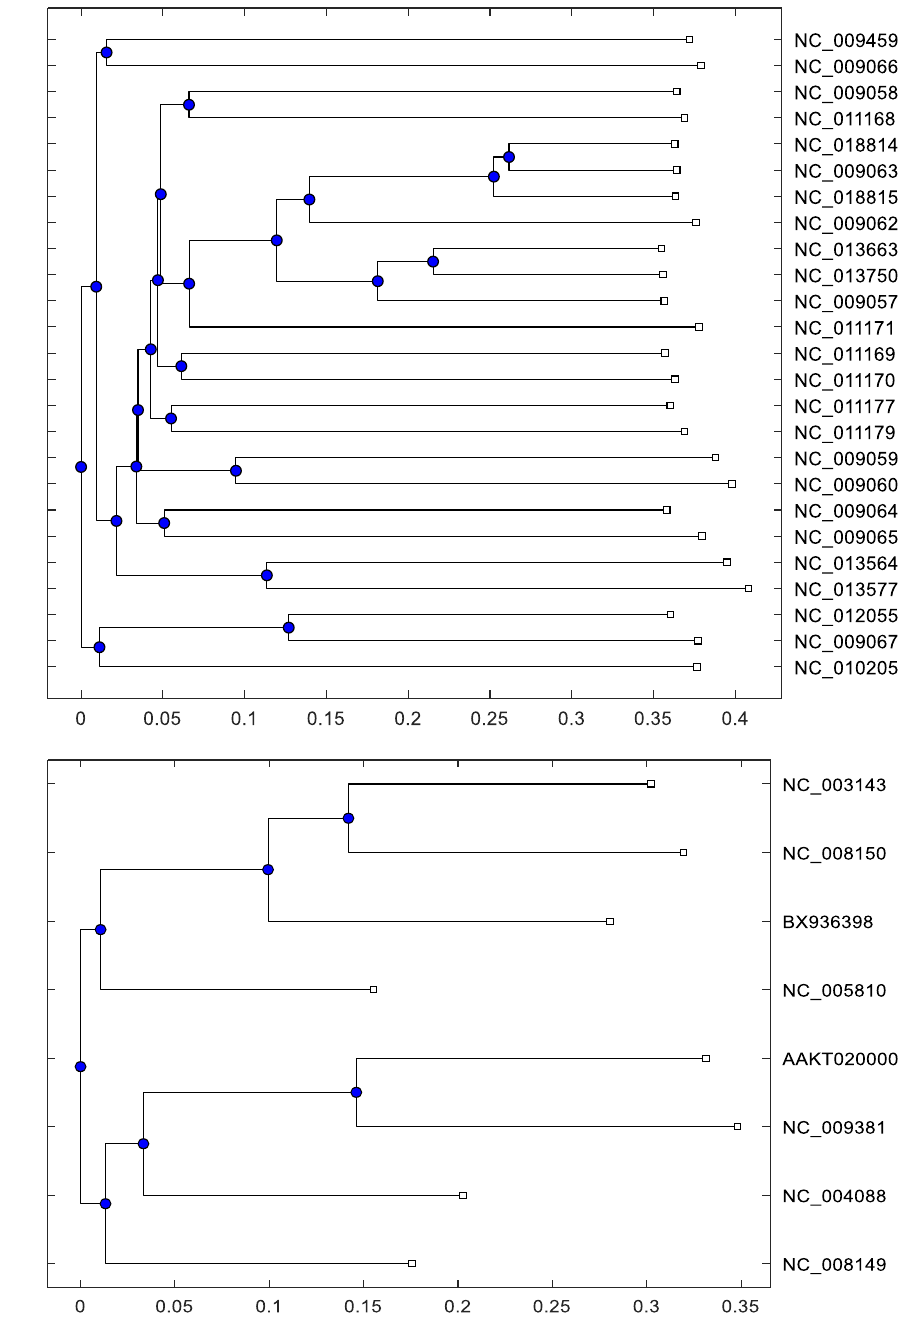
Fig. 3 Phylogenetic tree of 25 fish genome sequences described in Table 1. using our proposed method with k − mer = 8 and S r = 4